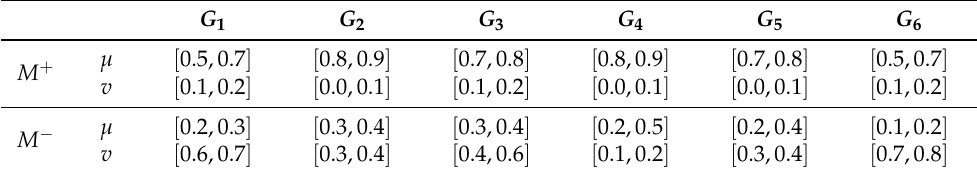
Table 5. The positive-ideal solution M + and the negative-ideal solution M − [21].